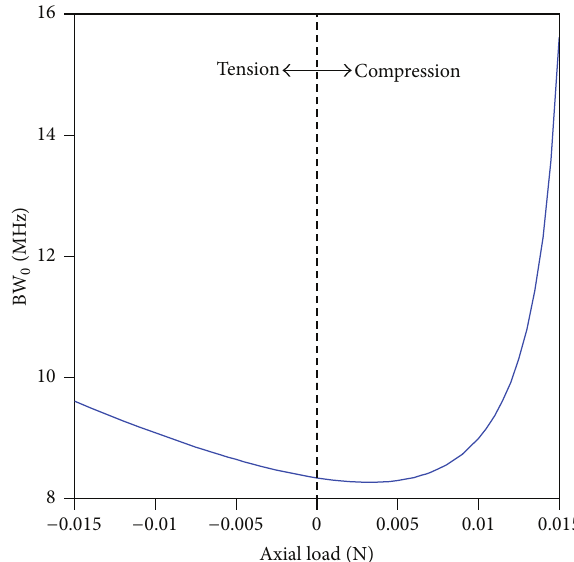
Figure 17: Variation of the bandwidth of the unactuated filter with axial load in the primary